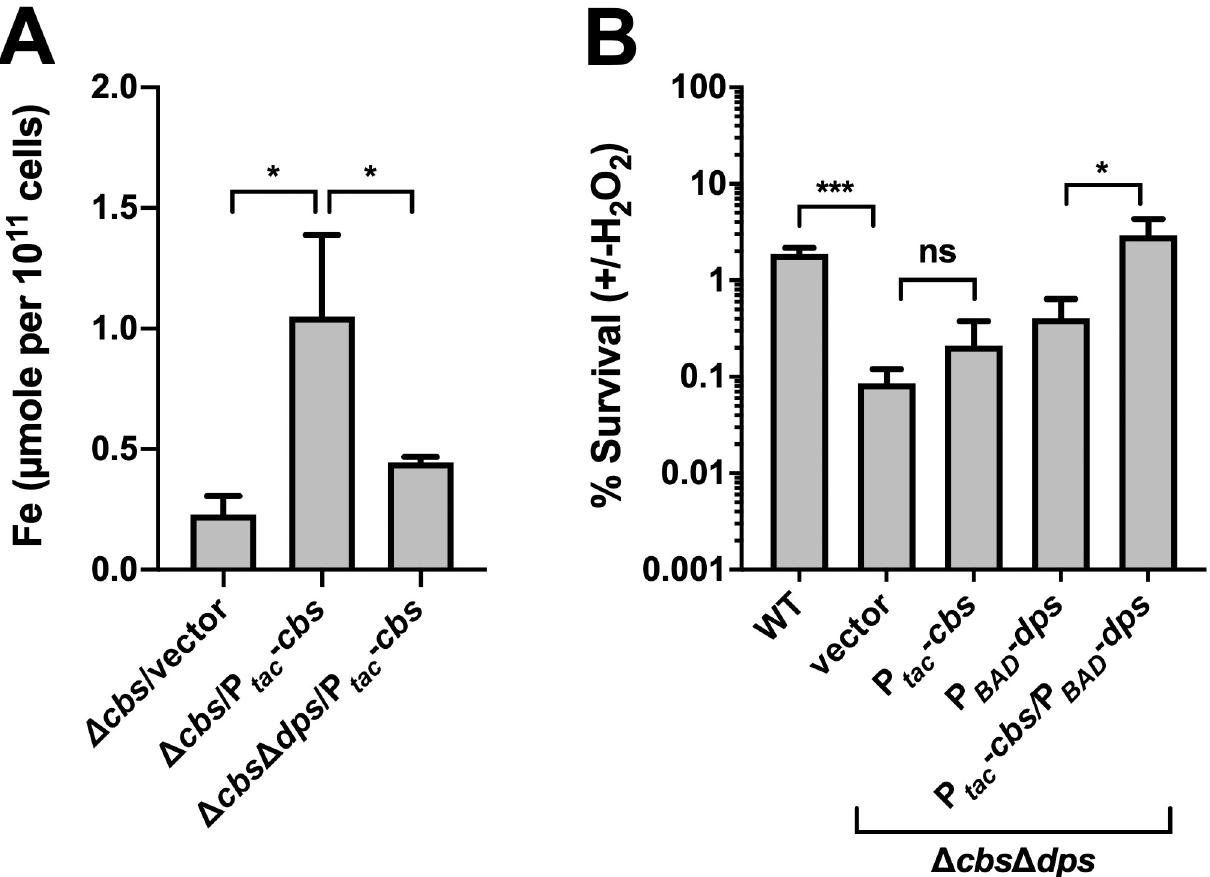
Fig 5. CBS-dependent ROS resistance works through promoting iron storage. (A). cbs expression promotes cellular iron storage. Cells were obtained in M9 minimal medium with 0.2% casein containing 0.5 mM IPTG and 0.02% arabinose. Iron content was assessed with ICP-MS and normalized with cell numbers. Values expressed are means ± S.D. from three experiments. Significance was determined by t -test; p -value: � , < 0.05. (B). cbs expression protects cells from H 2 O 2 in iron-deficient conditions. Bacteria were exposed to 1 mM of H 2 O 2 for 30 min at their exponential-phase or left untreated in M9 minimal medium (M9 salts plus 2 mM MgSO 4 , 0.1 mM CaCl 2 , and 0.2% casein acid hydrolysate as sole carbon source). Viability was determined by comparing the CFU in the H 2 O 2 -challenged and the unchallenged samples. Three replicates were sampled for each strain. Significance was determined by one-way ANOVA; p -value: � , < 0.05; ��� , < 0.001; ns, not